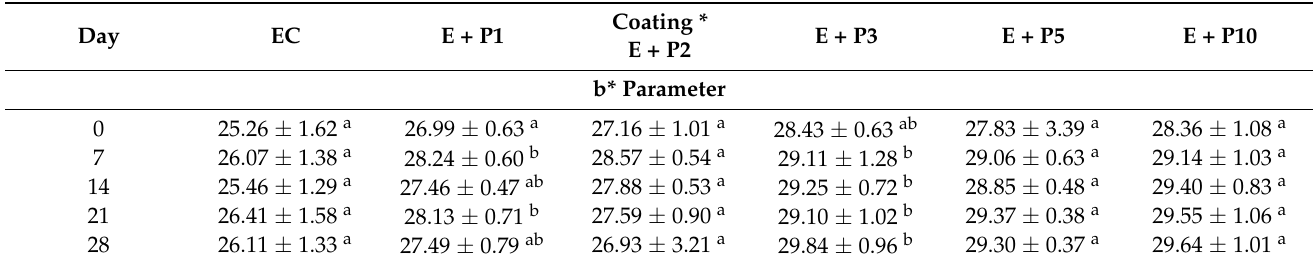
Table 3. Changes in b* parameter of the color of hen eggs coated with propolis extract at concentra- tions of 1, 2, 3, 5 and 10% during 28 storage